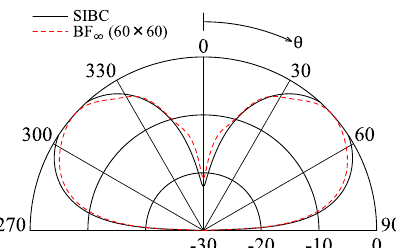
Fig. 10. Radiation patterns of half-wavelength dipole antenna at 15 GHz in z – x plane ( h = l /4) .